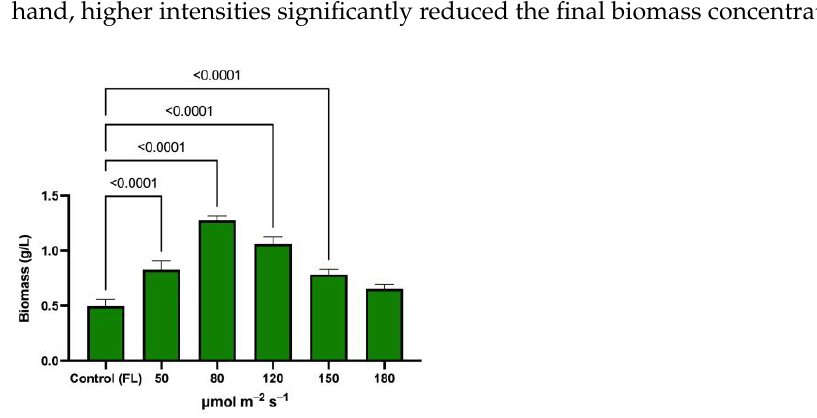
Figure 4. Biomass concentration under different intensities of white/red:blue LEDs.